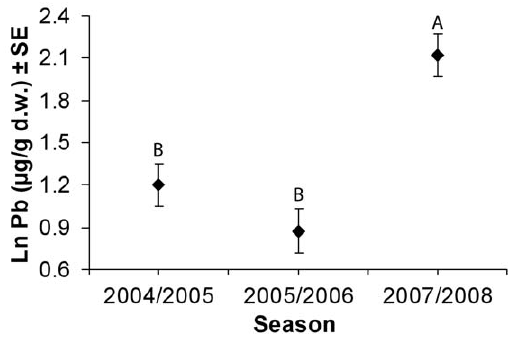
Figure 3. Estimated marginal means ( ± SE) of fecal Pb concentrations for purple gallinule at Entremuros by sampling season as obtained in a GLM model when considering Al as a covariable. Means sharing a capital letter did not differ significantly (LSD, p . 0.05).